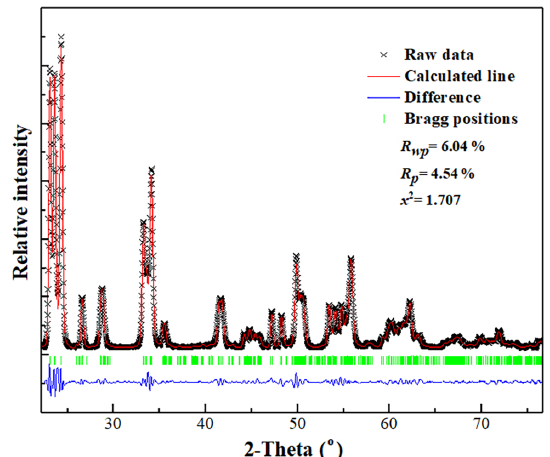
Figure 7. Fitting results of the Rietveld analysis in space group P 2 1 /n .